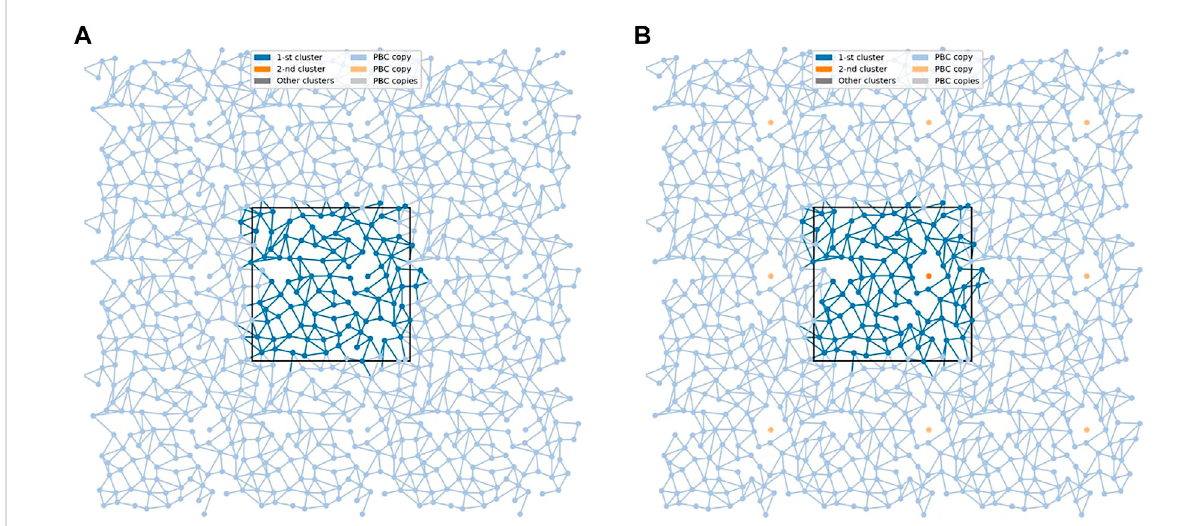
FIGURE 6 ThenetworksoflipidinterconnectionsattheinterfacesoftheDGDGbilayerattwotimeframes1psapart. (A) Thenetworkisconnectedand (B) the connected network is broken into two clusters. The black rectangle depicts the basic simulation box. Nodes (centres-of-mass of the lipids) are presented as dots in the x,y -plane, and edges as lines connecting respective nodes. The largest cluster is in blue and a single-node cluster is in orange . To avoid problems with edges crossing PBC, 9 copies of each node are presented (strong colour tone for the cluster, soft colour tones for its 8 PBC copies); the edges are drawn in the basic simulation box and all its